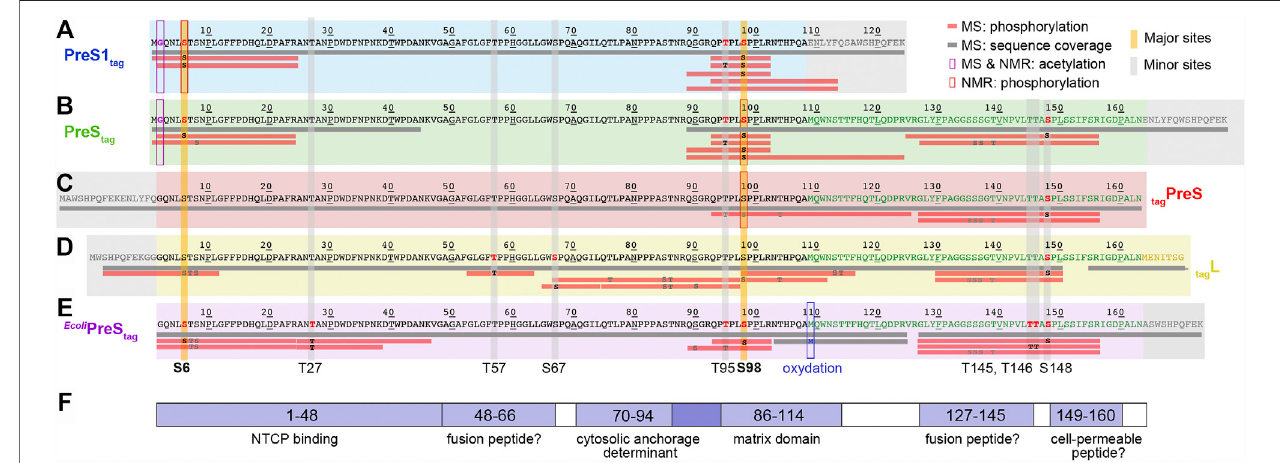
FIGURE2| Identi fi cation ofacetylation andphosphorylationsites inPreS1,PreS, andHBV L usingmassspectrometry and NMR. Massspectrometry analysishas been performed on fractions from puri fi ed protein samples shown on Figure 1 for cell-free synthesized PreS1 tag (A) , PreS tag (B) , tag PreS (C) , tag L (D) ; and MAPK14- E. coli PreS tag (E) . Horizontal gray bars below the sequences represent the sequence coverage by LC-MS/MS. Red bars represent peptides where one or more phosphorylation sites have been con fi rmed; the residues in black correspond to the phosphorylation sites formally identi fi ed, and the ones in gray correspond to possible but not con fi rmed sites. The PreS1 part of the amino-acid sequence is typed in black, the PreS2 part in green, the beginning of the S part in yellow (the full tag L protein was analyzed, but the sequence coverage of S was poor and no phosphorylation sites were detected), and the tag sequences in gray. Additional information extractedfromNMRchemicalshifts(seebelow)isshownaspurplesquaresforacetylationandredsquaresforphosphorylation.Majorphosphorylationsitesidenti fi edby mass spectrometry and NMR are highlighted by vertical yellow bars; minor sites (only mass spectrometry) by vertical gray bars. (F) Functional regions of the HBV PreS: binding to NTCP (Yan et al., 2012); possible fusion peptides (Pérez-Vargas et al., 2021); the MD (Bruss and Thomssen, 1994); and a possible cell-permeable peptide (Oess and Hildt,